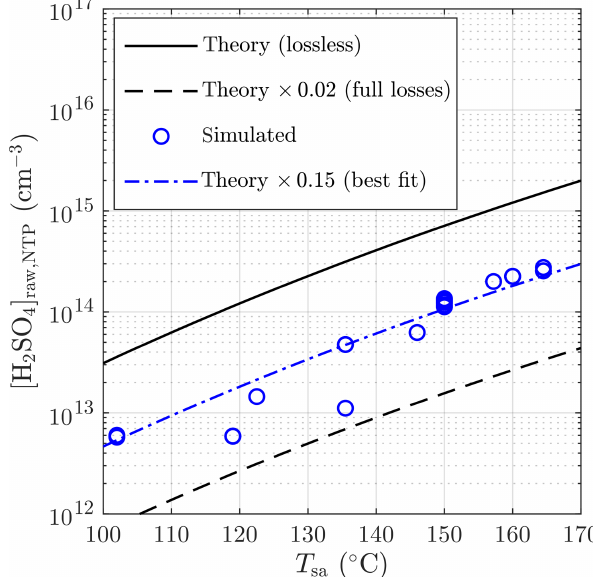
Figure 9. Simulated sulfuric acid concentrations in the raw sample compared to the theoretical concentrations with different sulfuric acid evaporator temperatures. The concentrations are presented as the concentrations in NTP (normal temperature and pressure) con- ditions rather than in a hot raw sample.